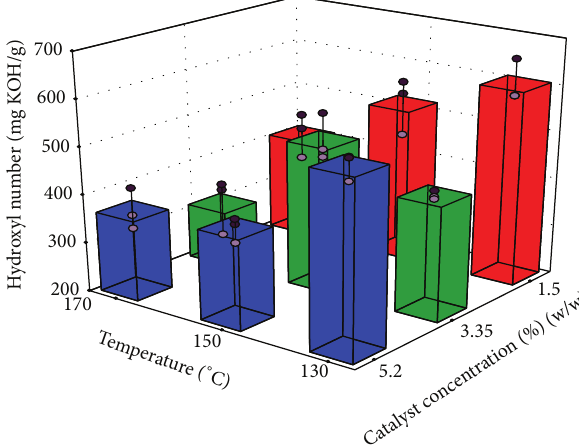
Figure 2: Temperature and catalyst concentration effect on polyg- lycerol hydroxyl number obtained from glycerol polymerization. Catalyst concentrations are shown: 1.5% (w/w) in red, 3.35% (w/w) in green, and 5.2% (w/w) in